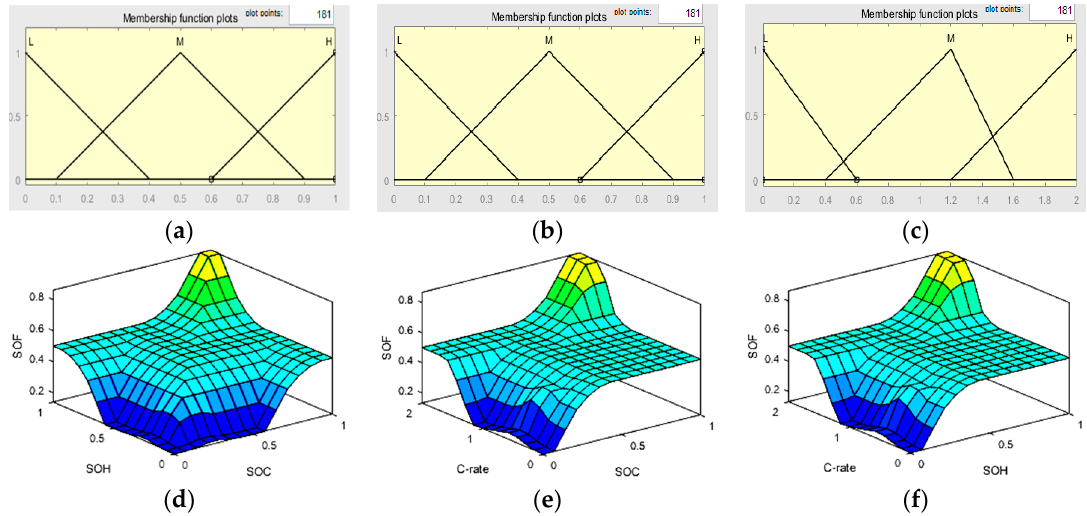
Figure 5. Input variable membership functions and three-dimensional graphs of fuzzy relations. ( a) –( c ) are input variable membership functions of state of charge (SOC), SOH and charge–discharge rate (C-rate), respectively. ( d )–( f ) are three-dimensional graphs of fuzzy relations of every two input variables of three corresponding to SOF.